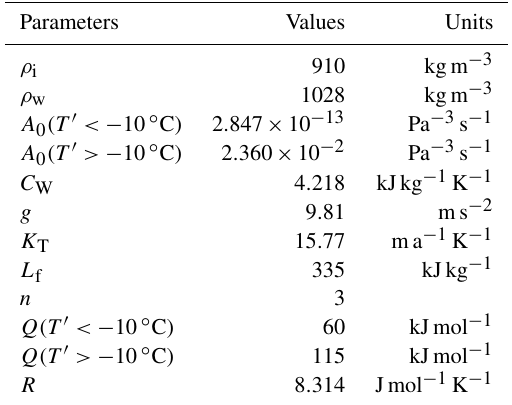
Table 1. List of parameter values used in this study. Parameters Values